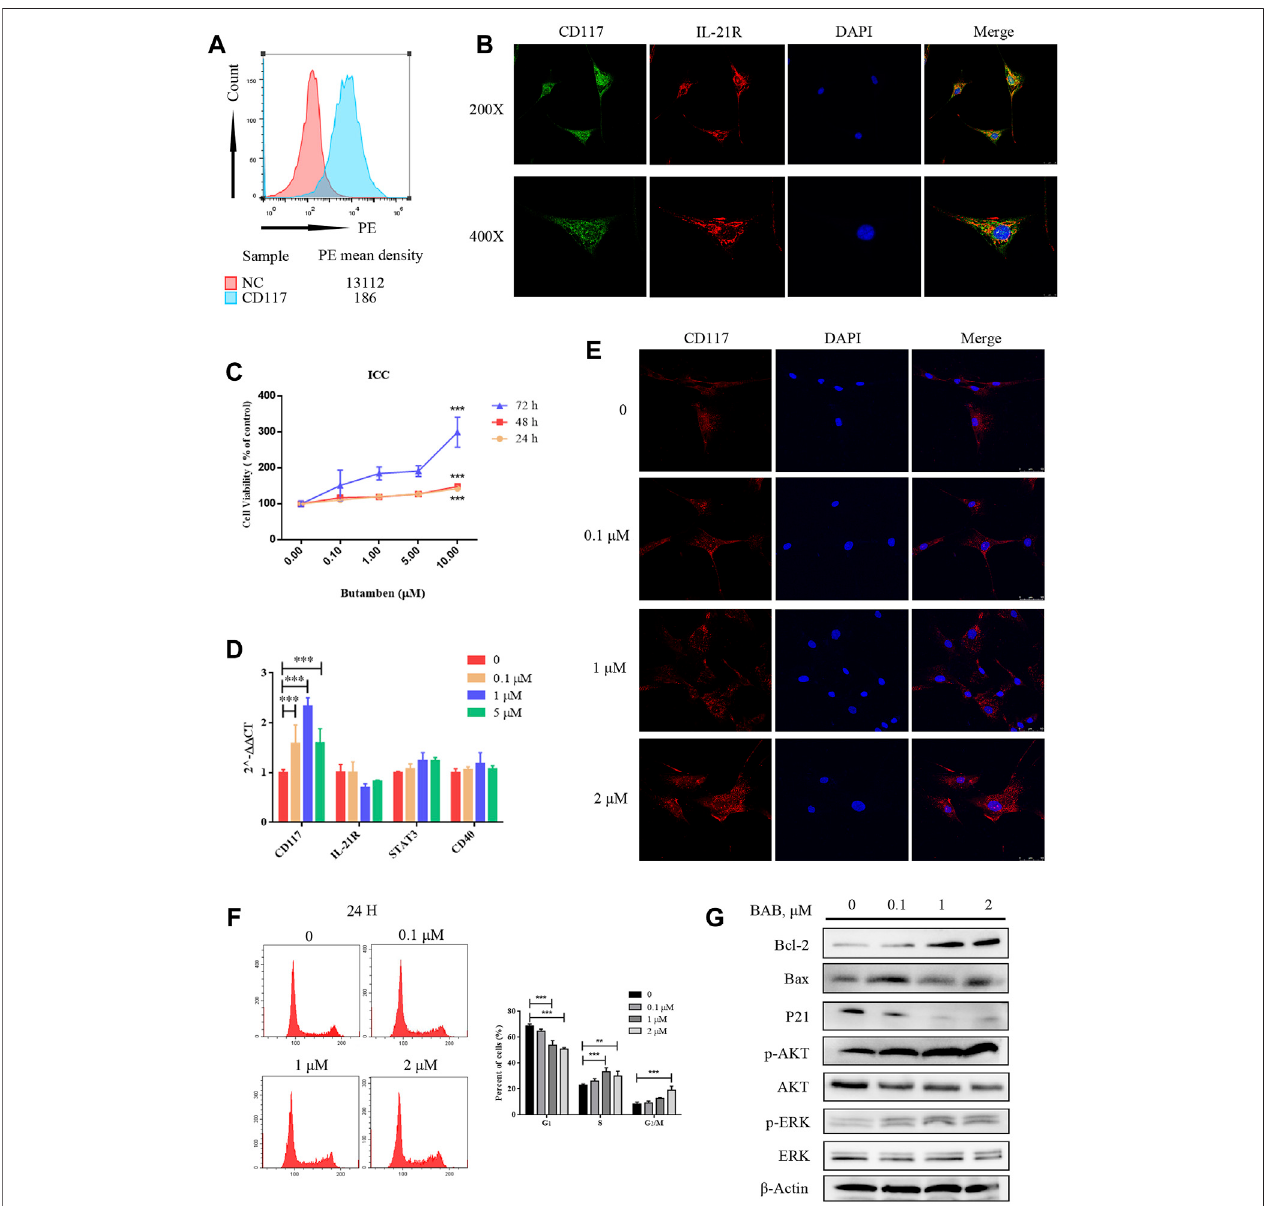
FIGURE 7 | The effect of BAB on human colonic interstitial cells of Cajal (ICC). (A) Flow cytometry showed the expression of c-kit in pre puri fi ed (red) and post puri fi ed(blue)cells; (B) CCK-8showedthatloperamidecouldalsoinduceconcentration-dependentapoptosisinICC; (C) immuno fl uorescenceidenti fi edtheexpression of IL-21R (red) and c-kit (green) in ICC; (D) qPCR detected the expression changes of related genes; (E) Cell immuno fl uorescence staining showed the expression of c-kit in human colonic ICC after treatment with different concentrations of BAB; (F) Cell cycle changes after treatment with BAB, the statistical analysis is listed on the right; (G) The expression of cell cycle-related proteins and the activation of Akt and ERK pathways were detected by Western blotting. ** p < 0.01, *** p < 0.001.